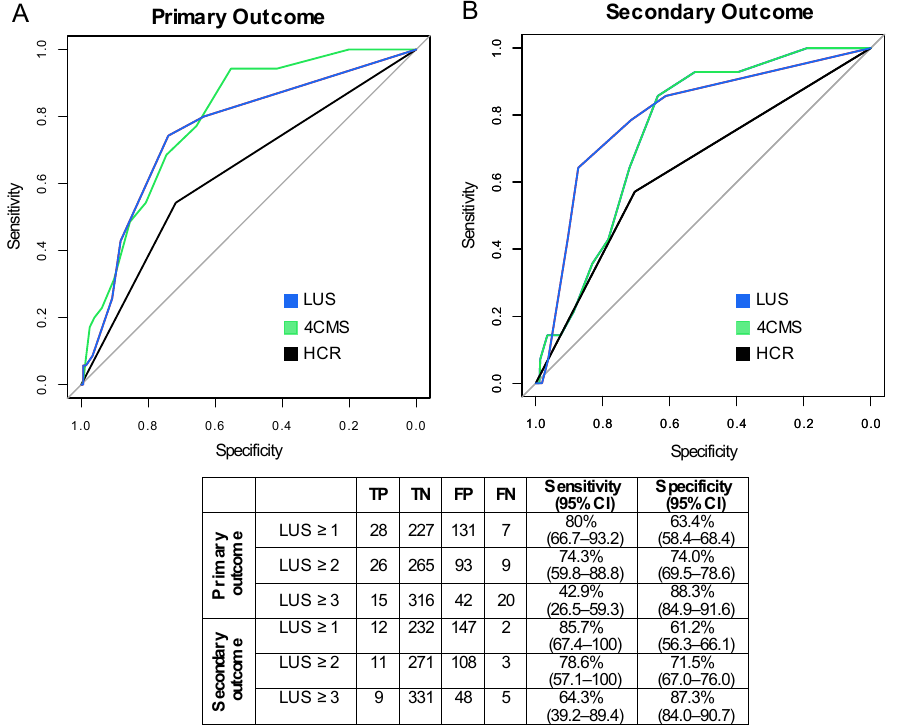
Figure 3. ROC curve analysis for prediction of ( A ) primary outcome and ( B ) secondary outcome. TP: True Positive; TN: True Negative; FP: False Positive; FN: False Negative.